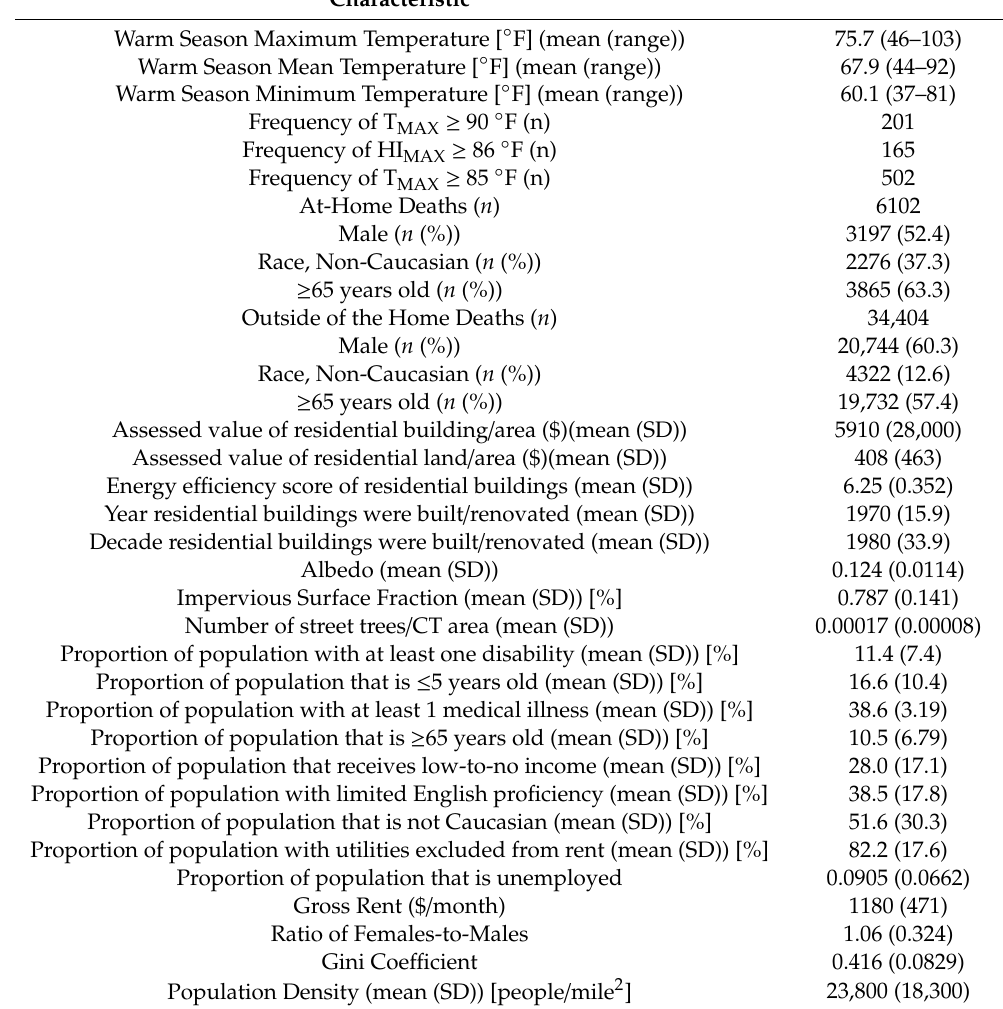
Table 1. Descriptive statistics for the Boston, MA warm season climate, analyzed deaths from all causes from 2000–2015, and small-area social and environmental parameters at the census tract (CT) level. The frequency (n) represents the number of days meeting that meteorological threshold or the number of deaths that met that